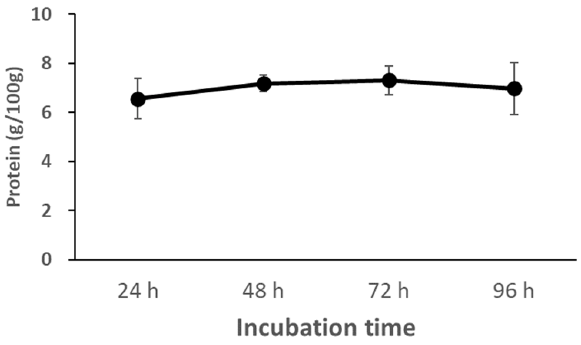
Figure 5. Changes in protein concentrations in mixtures of internal organs of white sturgeon reacted at 50 ◦ C for 96 h. Values are mean ( n =